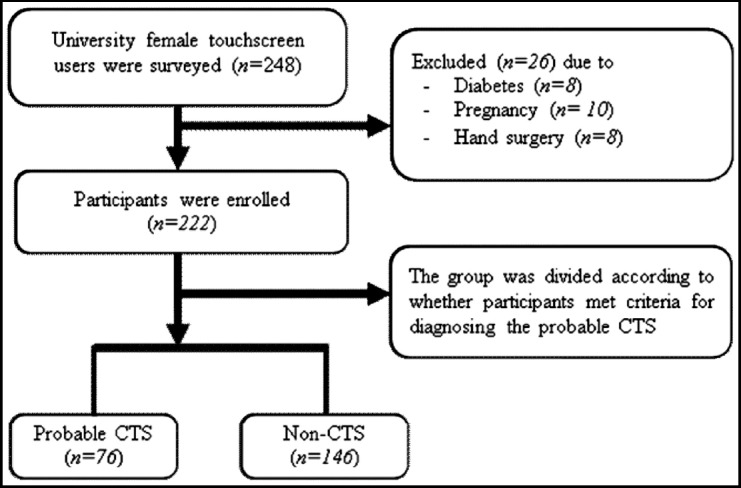
Study Flowchart of the female touchscreen users.